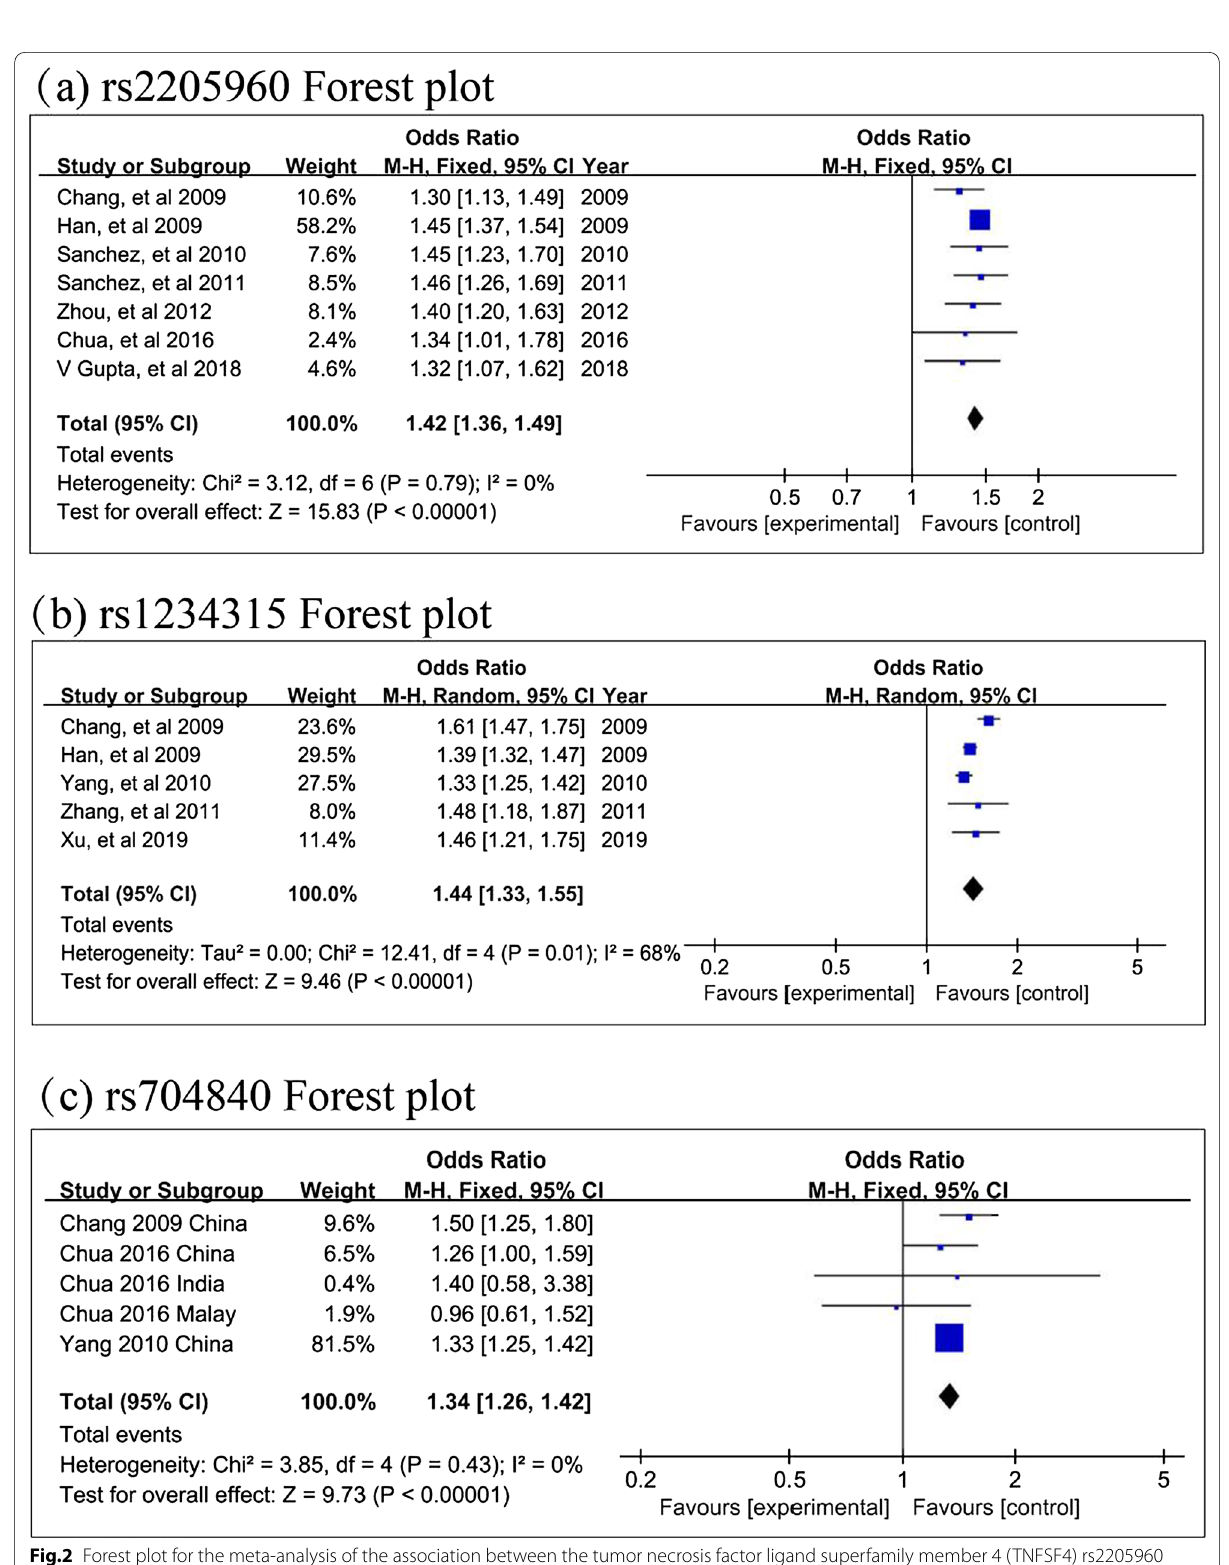
Fig.2 Forest plot for the meta‑analysis of the association between the tumor necrosis factor ligand superfamily member 4 (TNFSF4) rs2205960 polymorphism (Tvs.G) ( a ), rs1234315 polymorphism (Tvs.C) ( b ), rs704840 polymorphism ( c ) and